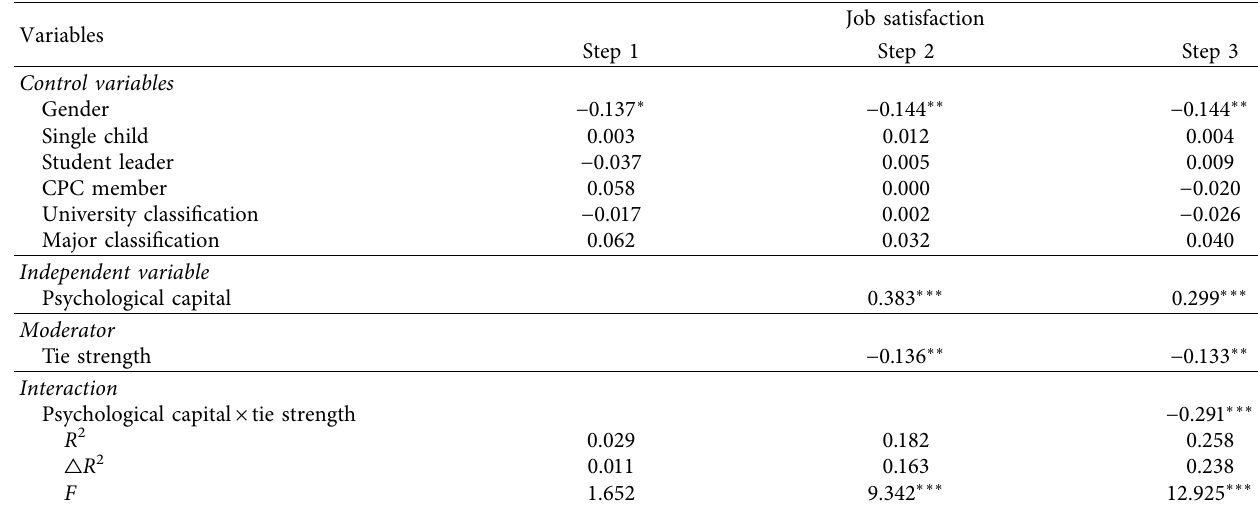
Job satisfaction Step